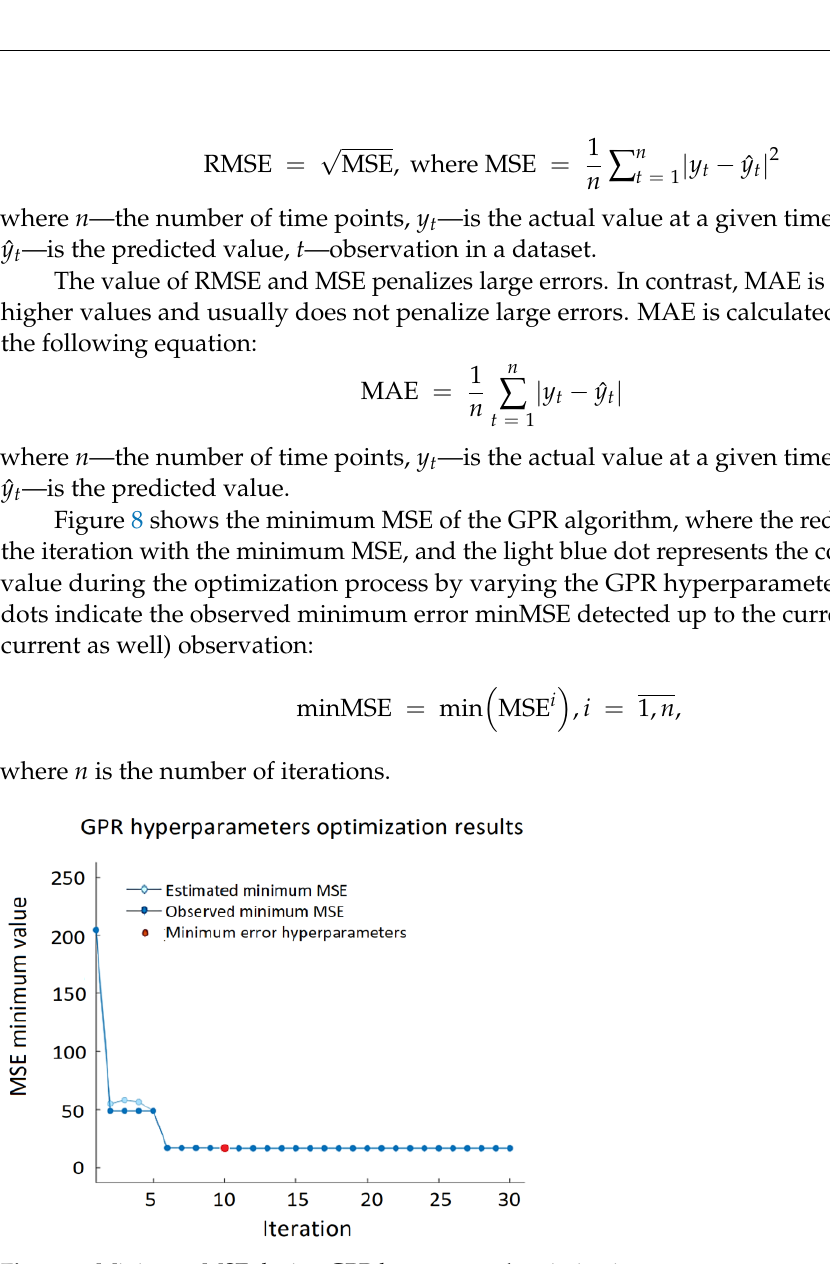
Figure 9. Testing data results of the GPR model.